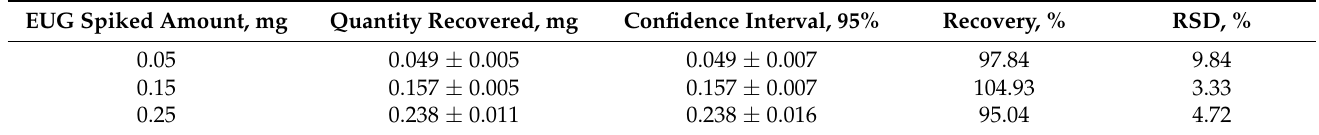
Table 2. Recovery results of EUG spiking